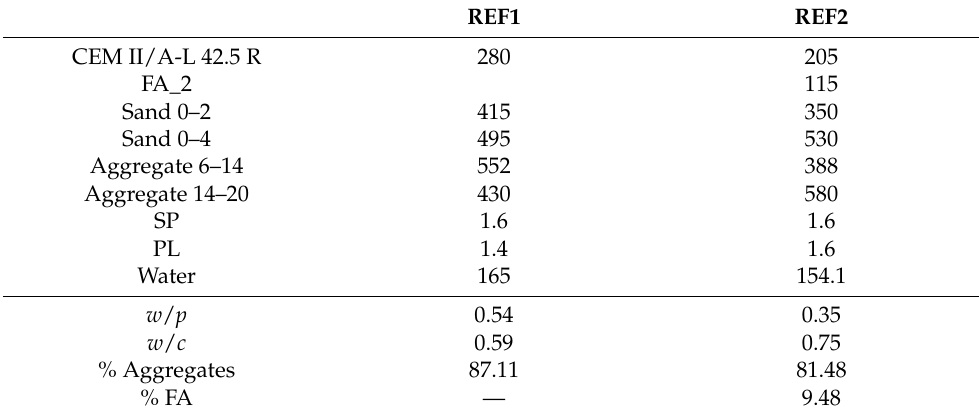
Table 2. Reference mixture compositions, REF1 and REF2 [kg/m 3 or L/m 3